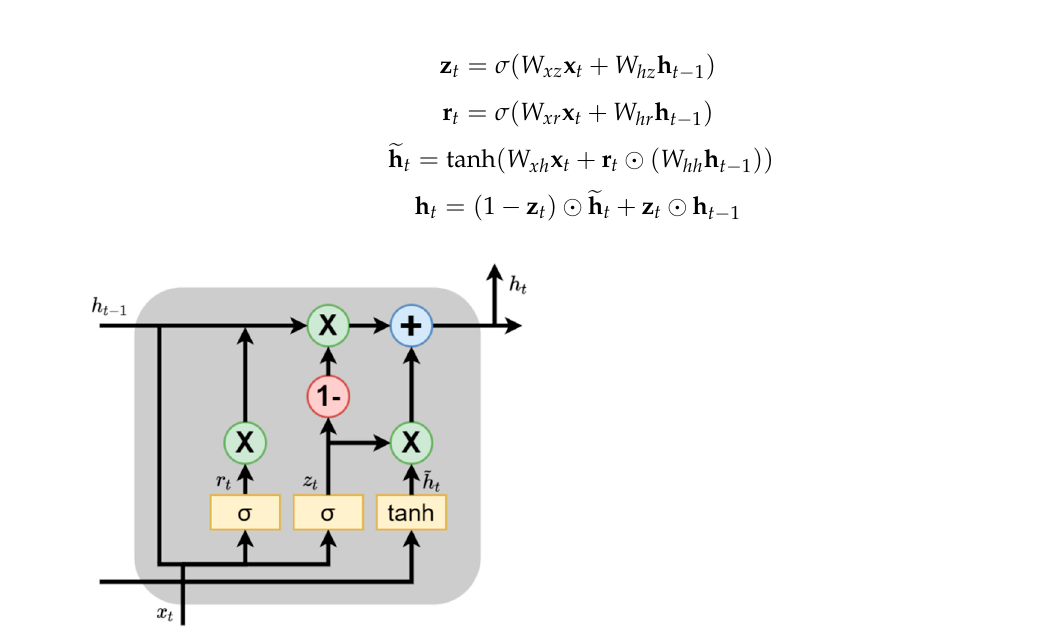
Figure 6. Basic structure of GRU.